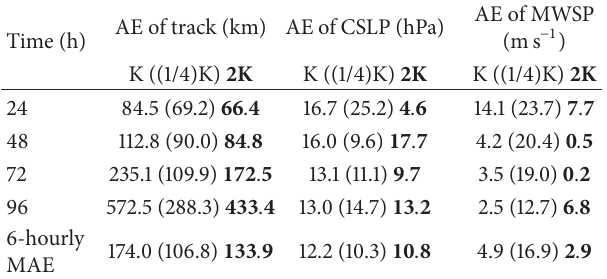
Table 5: Case 4-Phanfone: AE and MAE of track, CSLP, and MWSP.